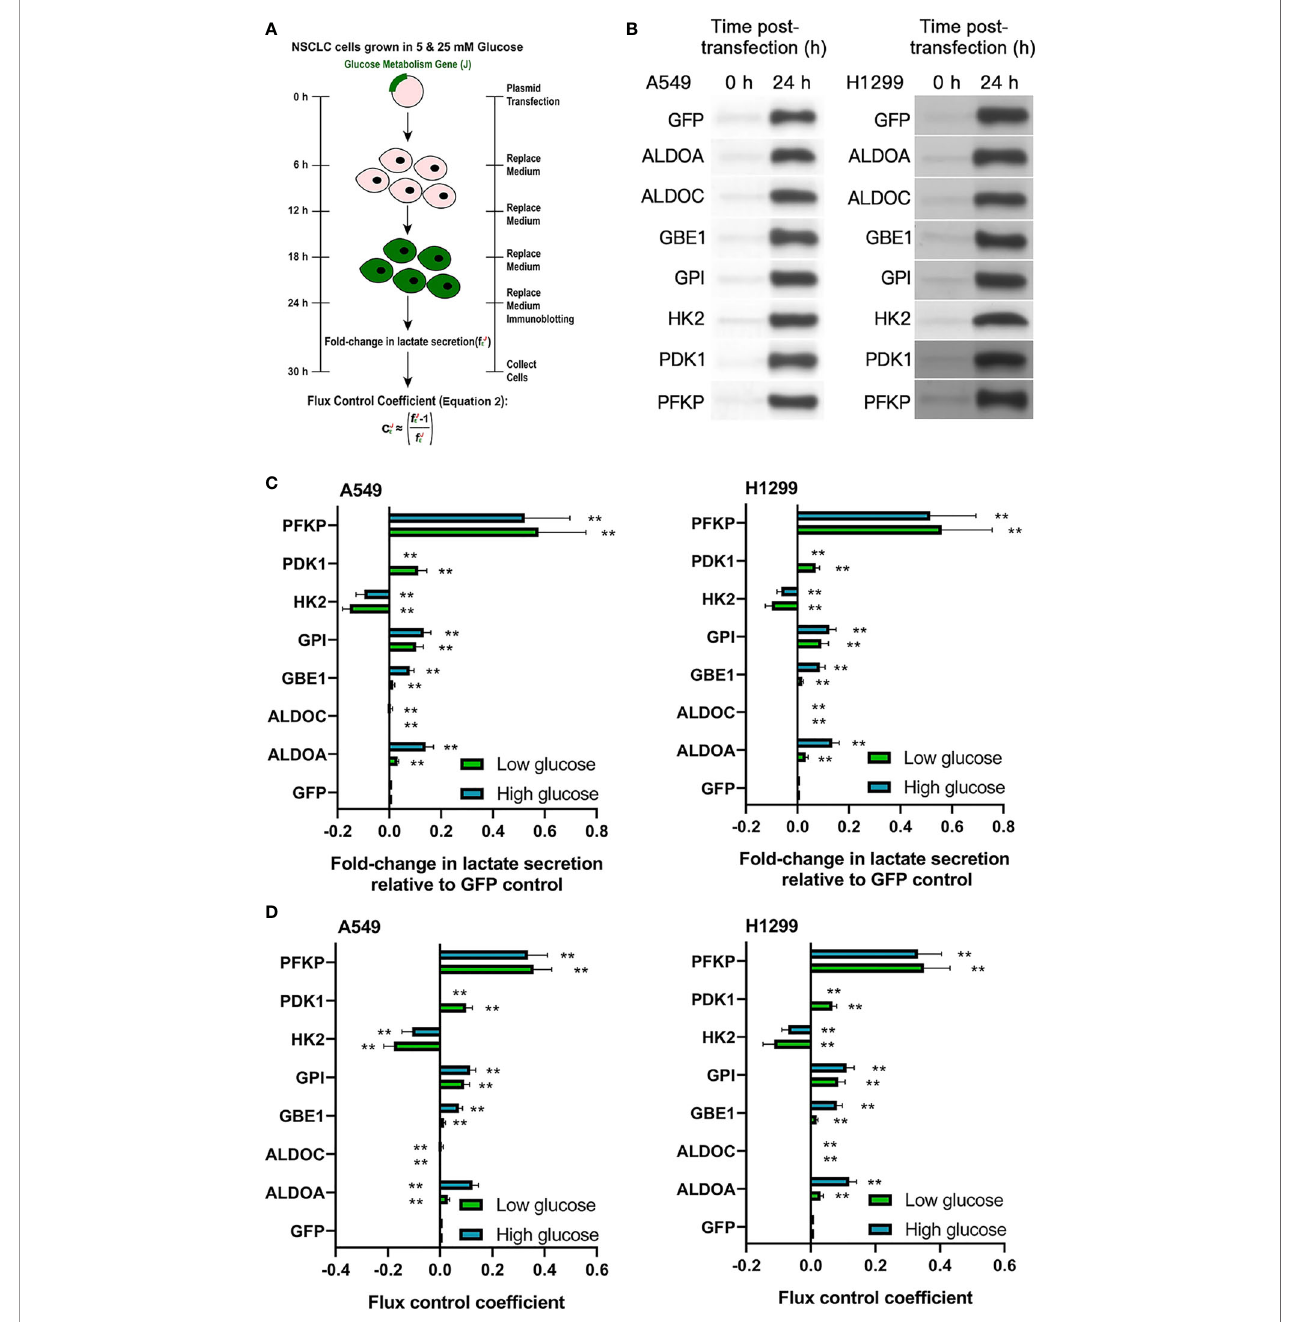
FIGURE 2 | The HIF-1 a target gene PFKP controls glycolytic fl ux in NSCLC cell lines. (A) Schematic of glycolytic fl ux experiments in A549 and H1299 NSCLC cells. The seven glucose metabolism genes identi fi ed in Figure 1 were individually overexpressed in A549 and H1299 cells. Glycolytic fl ux was assessed from 24 – 30 h post-transfection with the f E parameter: lactate secretion in gene-overexpressing cells/lactate secretion in GFP-expressing control cells. (B) Immunoblots validating gene overexpression in A549 and H1299 cells at 24 h post-transfection. (C) f E values under low glucose (5 mM) conditions (green bars) or high glucose (25 mM) conditions (blue bars) and (D) associated fl ux-control coef fi cients (C E ) de fi ned in (A) . Data represented as means ± SDs. n = 3 biological replicates × two technical replicates. * P < 0.05, ** P < 0.01 [unpaired Student ’ s t -test vs . glucose condition-matched GFP con fi rmed a reduction in Ki-67 + ve cell counts in HBO-treated ( Figure 4B and Figure S7A ). Lung tumor counts and mean tumor lung tumors, an effect abrogated by Pfkp overexpression volumes were signi fi cantly reduced in HBO-treated mice, an effect ( Figure 4E ). IHC staining revealed Hif-1 a , Pfkp, and p- b -catenin abrogated by Pfkp overexpression ( Figures 4C, D ). IF staining